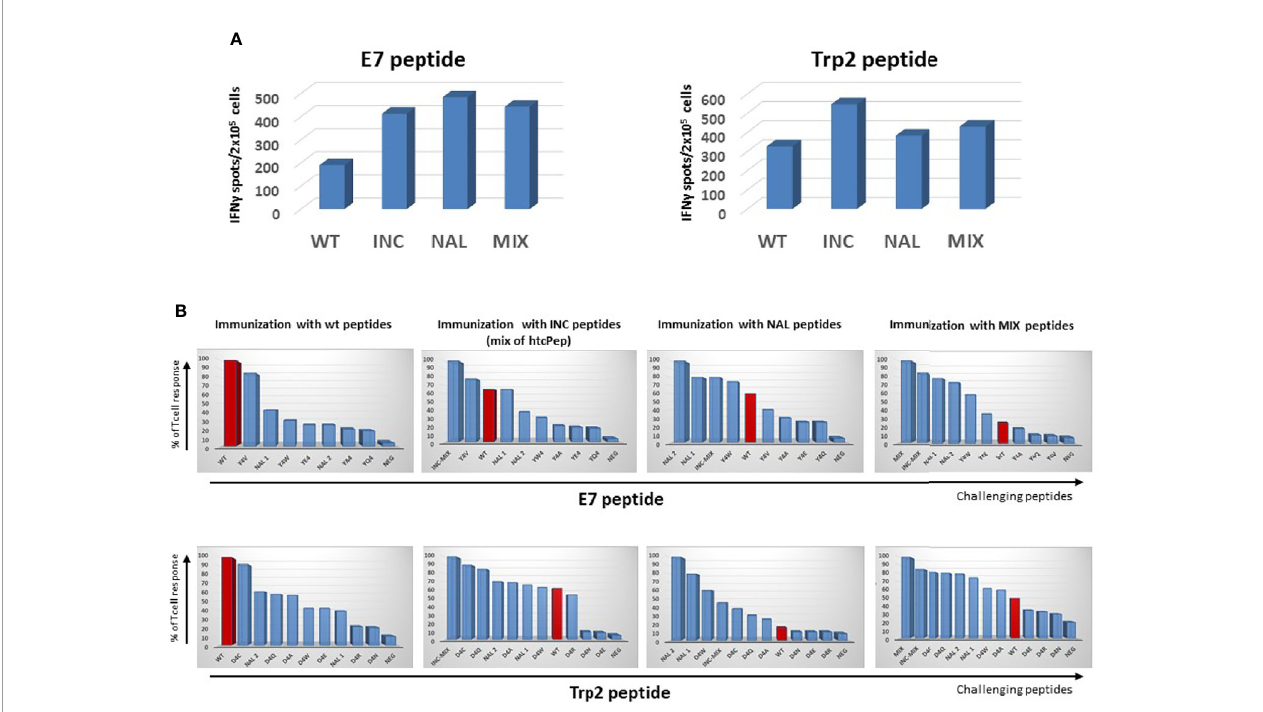
FIGURE 1 | Cross-reactive T cell response. C57BL/6 mice were immunized with indicated peptides and an IFN- g EliSpot assay was performed re-stimulating ex vivo splenocytes with the indicated challenging peptides. (A) Absolute immune responses elicited by wild type and heteroclitic peptides. (B) Percentage of T cell response compared to the one observed by re-stimulation with the same peptide used in the immunization (= 100).